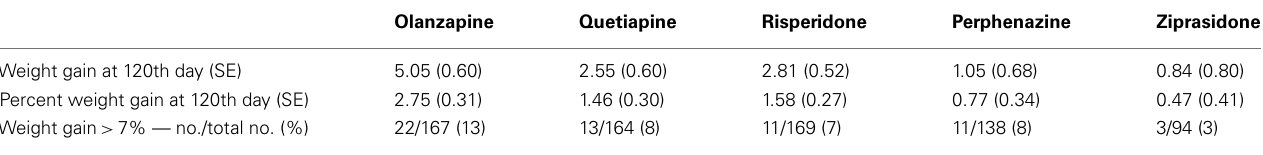
Table 3A |Weight measures without adjusting for covariates (Model 1: weight gain was estimated using combined data for all treatments).